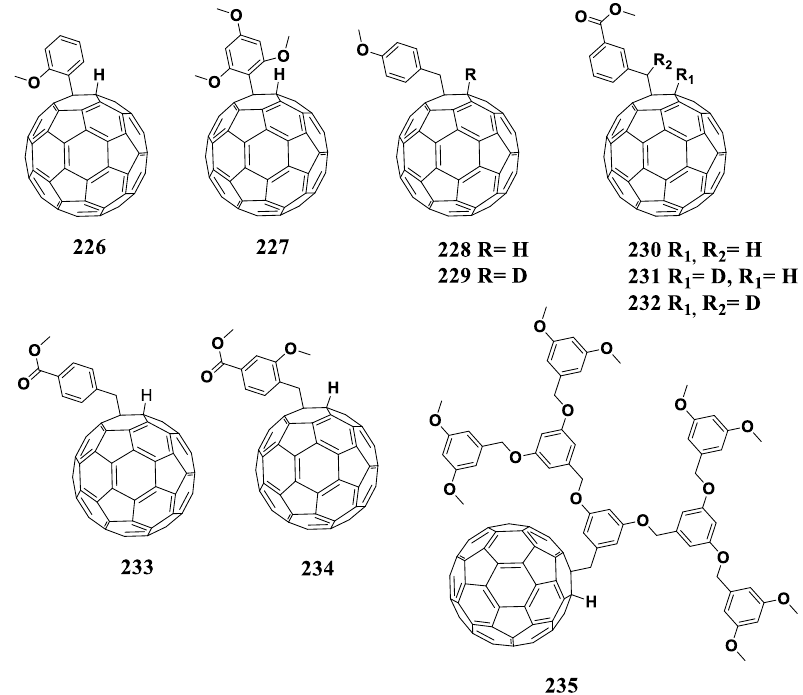
Figure 19. Molecular structures of 1,2-adducts of fullerene C 60 with reduced electron affinity.